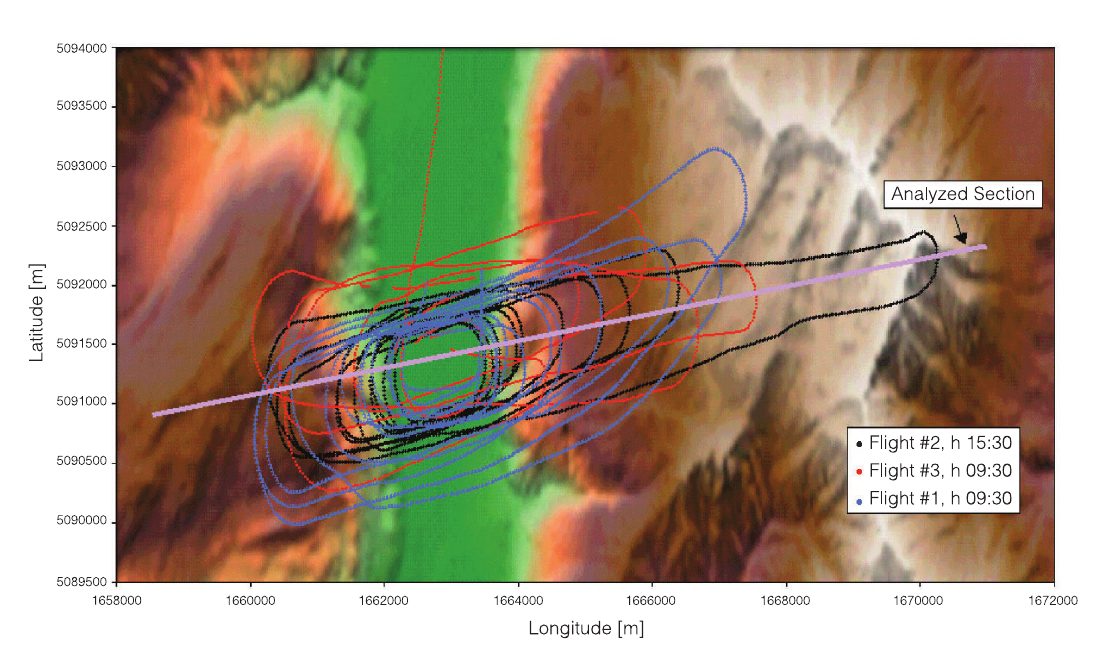
Fig. 5. Plan view of fl ight trajectories of subsequent fl ights over target area «Besenello». The straight line indicates the vertical cross section used for mapping in fi gs. 9 to 11.